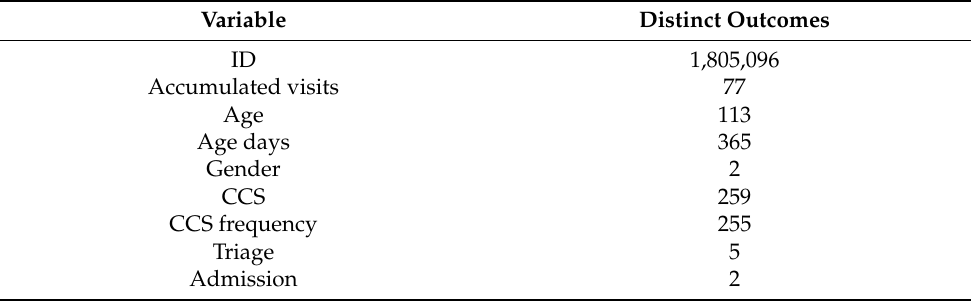
Table 2. Variable included in the